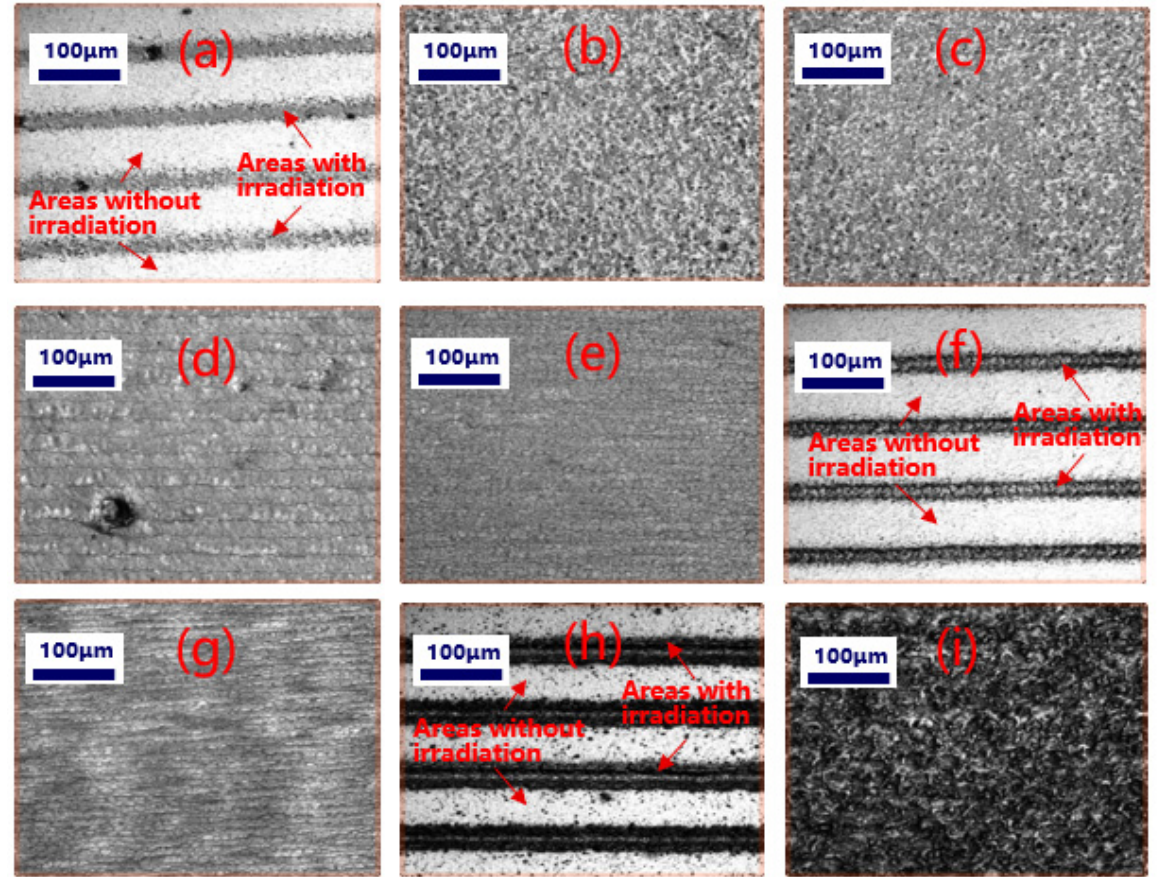
Figure 12. Surface roughness after laser surface modification: ( a ) Ra = 58 nm; ( b ) Ra = 68 nm; ( c ) Ra = 64 nm; ( d ) Ra = 149 nm; ( e ) Ra = 44 nm; ( f ) Ra = 256 nm; ( g ) Ra = 177 nm; ( h ) Ra = 144 nm; ( i ) Ra = 137 nm.